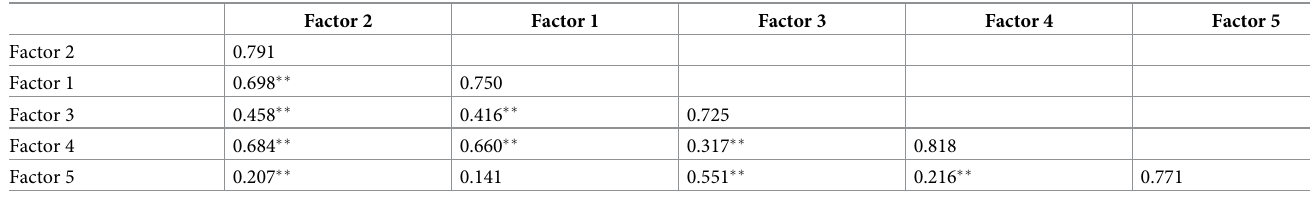
Table 5. The discriminant validity test results of the measurement model. Factor